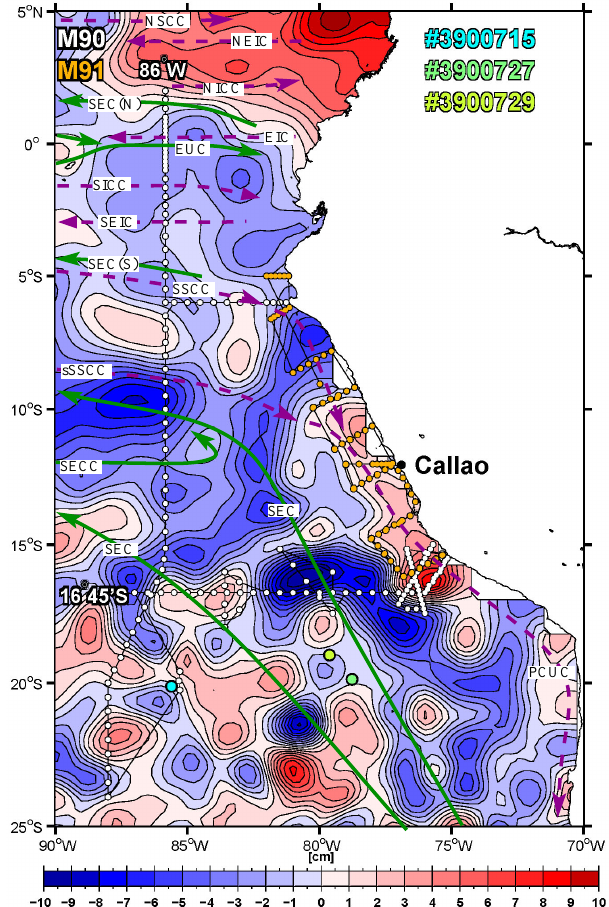
Figure 1. Aviso sea level height anomaly (in cm) for 21 Novem- ber 2012, cyclonic features are shown in blue, anticyclonic ones in red. The cruise track (black line) and conductivity–temperature– depth (CTD) stations of R/V Meteor cruise M90 in November 2012 (white dots) and of cruise M91 in December 2012 (yellow dots) are included. The deployment locations of the three floats used here are marked by filled greenish circles with the related world mete- orological organization (WMO) number shown in the right upper corner. Near-surface currents are shown as solid green lines, sub- surface currents as dashed magenta lines. Abbreviations for current bands are listed in the